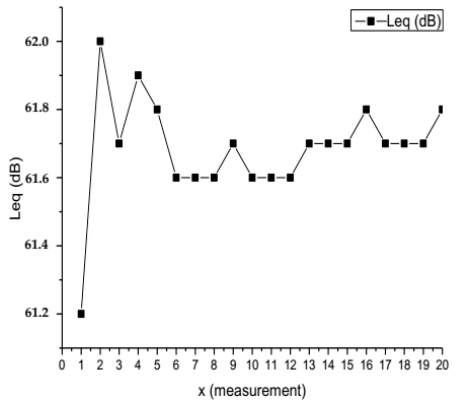
Figure 18. The 180 ◦ oriented building block toward runway. Figure 18. The 180° oriented building block toward runway. Figure 18. The 180° oriented building block toward runway.